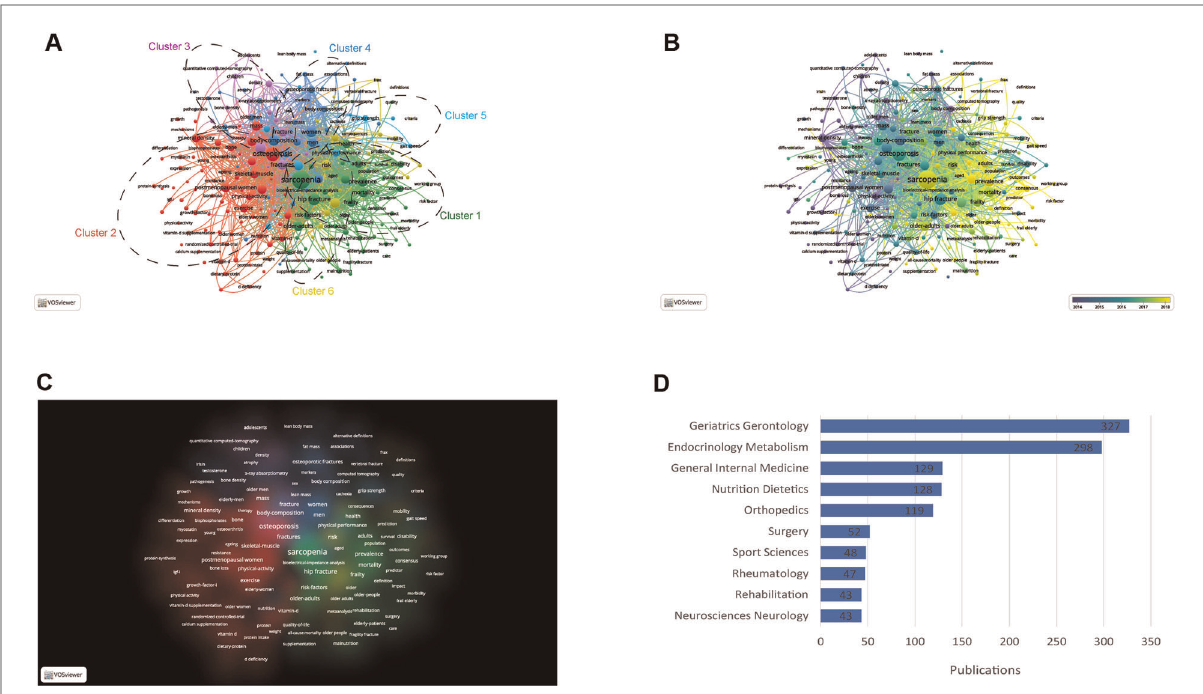
FIGURE 7 Analysis of keywords and analysis of subjects and directions. ( A ) Network visualization of the keywords co-occurrence analysis (generated by VOSviewer). The size of nodes is proportional to the co-occurrence times of keywords, and the color presents different clusters. The thicker the lines between two nodes, the higher the frequency of their co-occurrence; ( B ) average year map of keywords co-occurrence analysis (generated by VOSviewer). The size of nodes is proportional to the co-occurrence times of keywords, and the color presents on the average appearing year of each keyword. The thicker the lines between two nodes, the higher the frequency of their co-occurrence; ( C ) density distribution of keywords co-occurrence analysis (generated by VOSviewer). The density in the fi gure is proportional to the co-occurrence times of keywords; ( D ) distribution of subjects and directions of